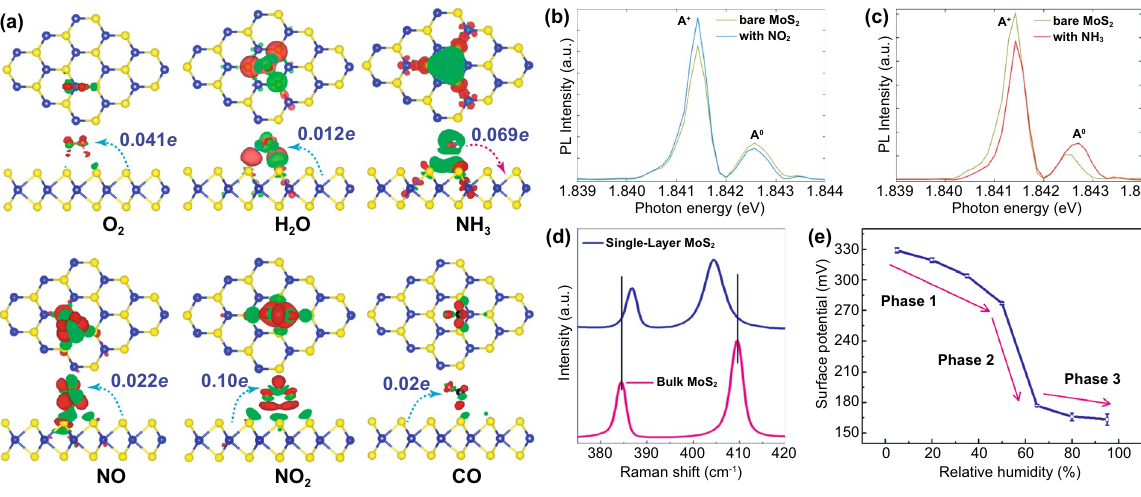
Fig. 11 a Charge density difference plots for O 2 , H 2 O, NH 3 , NO, NO 2 , and CO interacting with monolayer MoS 2 . The red (green) distribution corresponds to charge accumulation (depletion). The isosurface is taken as 5 × 10 −4 e Å −3 . The direction and value of charge transfer are also denoted. Reprinted from Ref. [175]. Copyright 2013, Springer Inc. In situ PL spectra recorded from the MoS 2 with b NO 2 and c NH 3 molecules. Reprinted from Ref. [174]. Copyright 2015, Springer Nature. d Raman spectrum of bilayer MoS 2 sheet before and after exposure to 1000